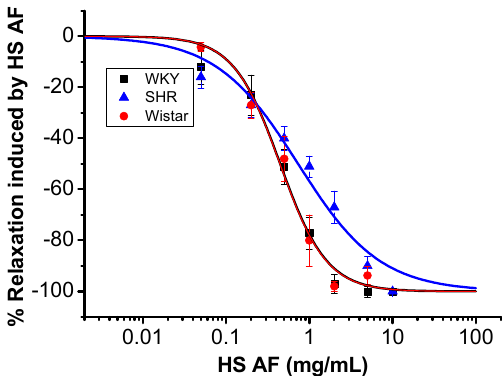
Figure 3. Concentration effect curve of HS AF on isolated mesenteric arteries (MA) rings of Wistar rat MA and WKY and SHR pre-contracted by 10 µM PE. Values are expressed as mean ± SEM (n = 9 / 5 for WKY, n = 8 / 4 for SHR, and n = 9 / 5 for Wistar). Relaxation was calculated as a percentage of the initial contraction.